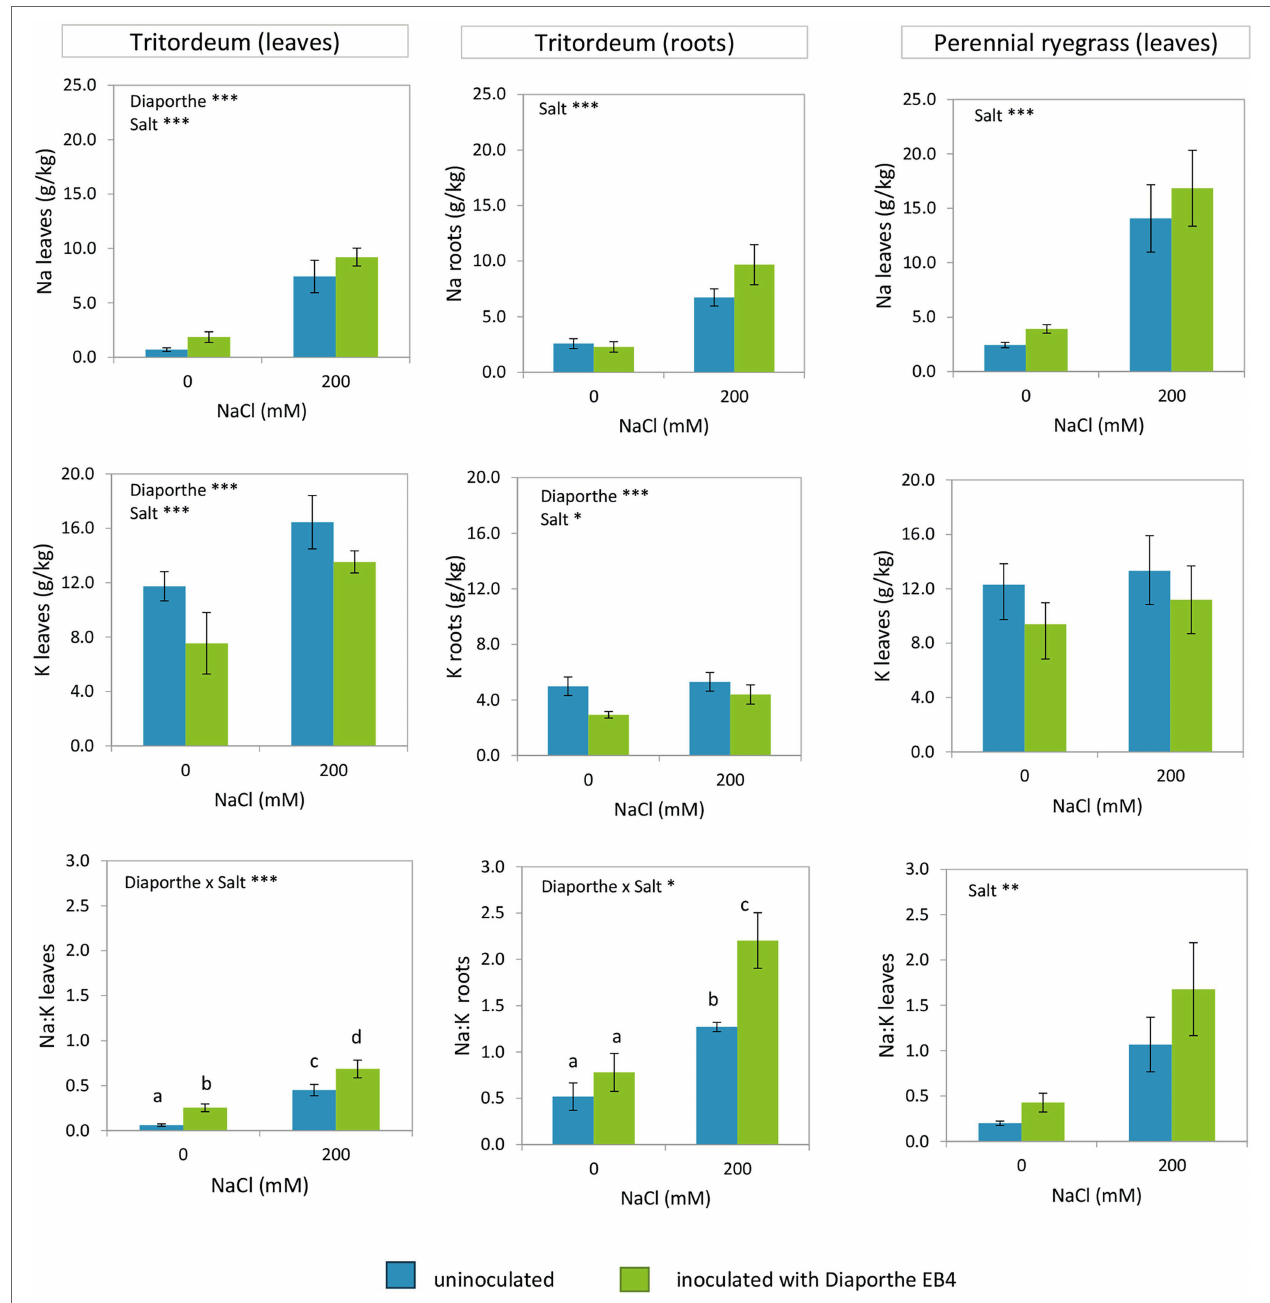
FIGURE 2 | Sodium and potassium content in leaves and roots of tritordeum and leaves of perennial ryegrass plants not inoculated ( BLUE ) or inoculated with Diaporthe EB4 ( GREEN ), at two different salinity treatments (0 and 200 mM NaCl). Values are means ± SD ( n = 6). When the interaction [ Diaporthe inoculation × salinity] was significant, different means are indicated with different letters (Tukey test p < 0.05). Significant effects of “ Diaporthe inoculation” and/or “salinity” are indicated